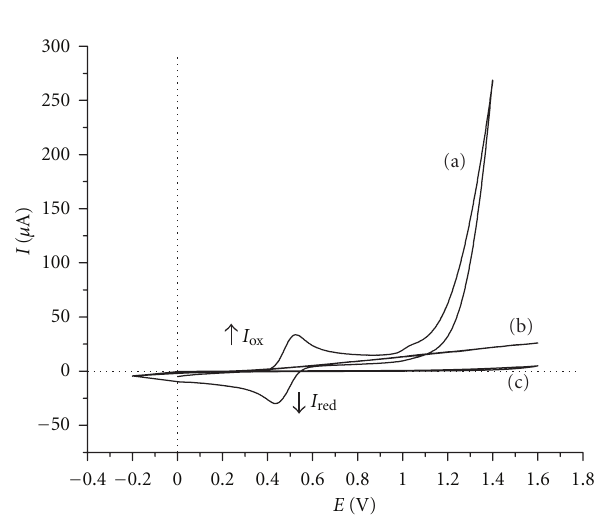
Figure 4: (a) The CV of 1.0mM DAnPS at Pt electrode (disk shape, 1.6mm diameter) recorded in DMF and LiClO 4 as supporting electrolyte; (b) the CV of 1.0mM DAnPS in DMF-free electrolyte support (LiClO 4 ); (c) the CV of the DMF-LiClO 4 monomer-free solution; scan rate: 50mVs − 1